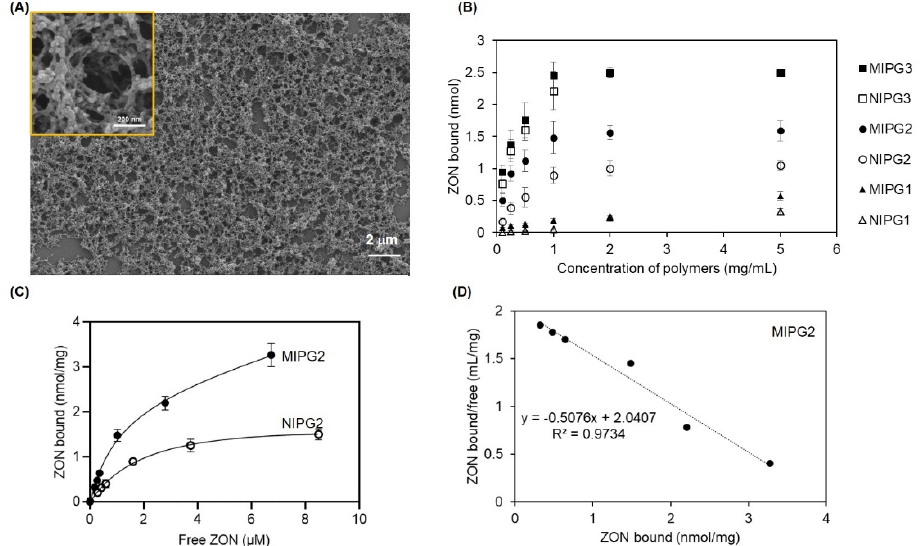
Figure 1. ( A ) SEM image of the MIPGs_ZON. ( B ) Equilibrium binding isotherms for 2.5 µ M ZON on MIPGs_ZON at concentrations ranging from 0.1 to 5 mg/mL in 1 mL ACN. Data are means from three independent experiments. The error bars represent standard deviations. ( C ) Determination of the binding capacity of 1 mg MIPG2 and NIPG2 towards ZON varying from 0.5 to 10 µ M in 1 mL ACN, respectively. Data are means from three independent experiments. The error bars represent standard deviations. ( D ) Corresponding Scatchard plot of MIPG2.